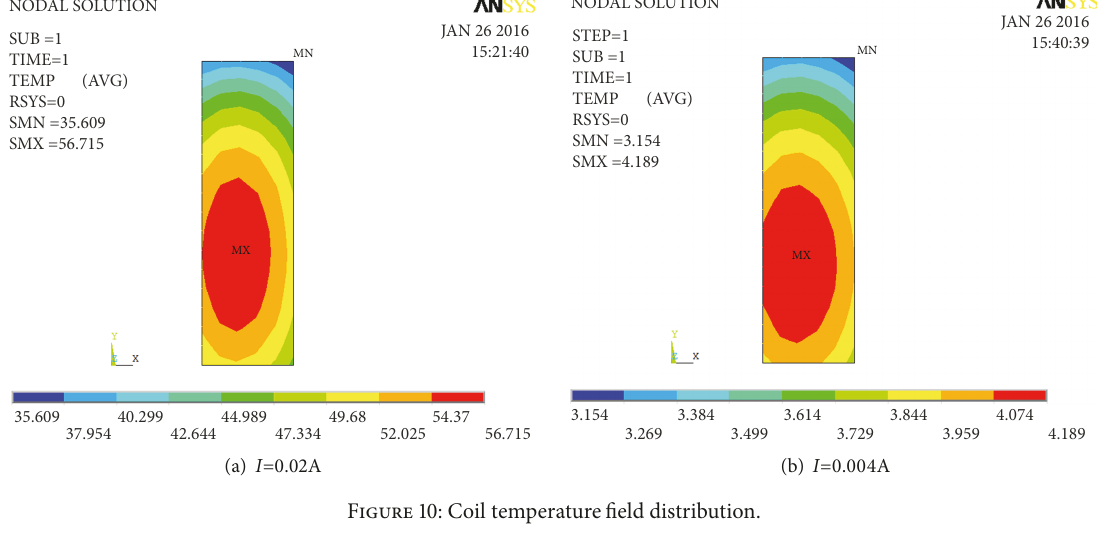
Figure 10: Coil temperature field distribution.